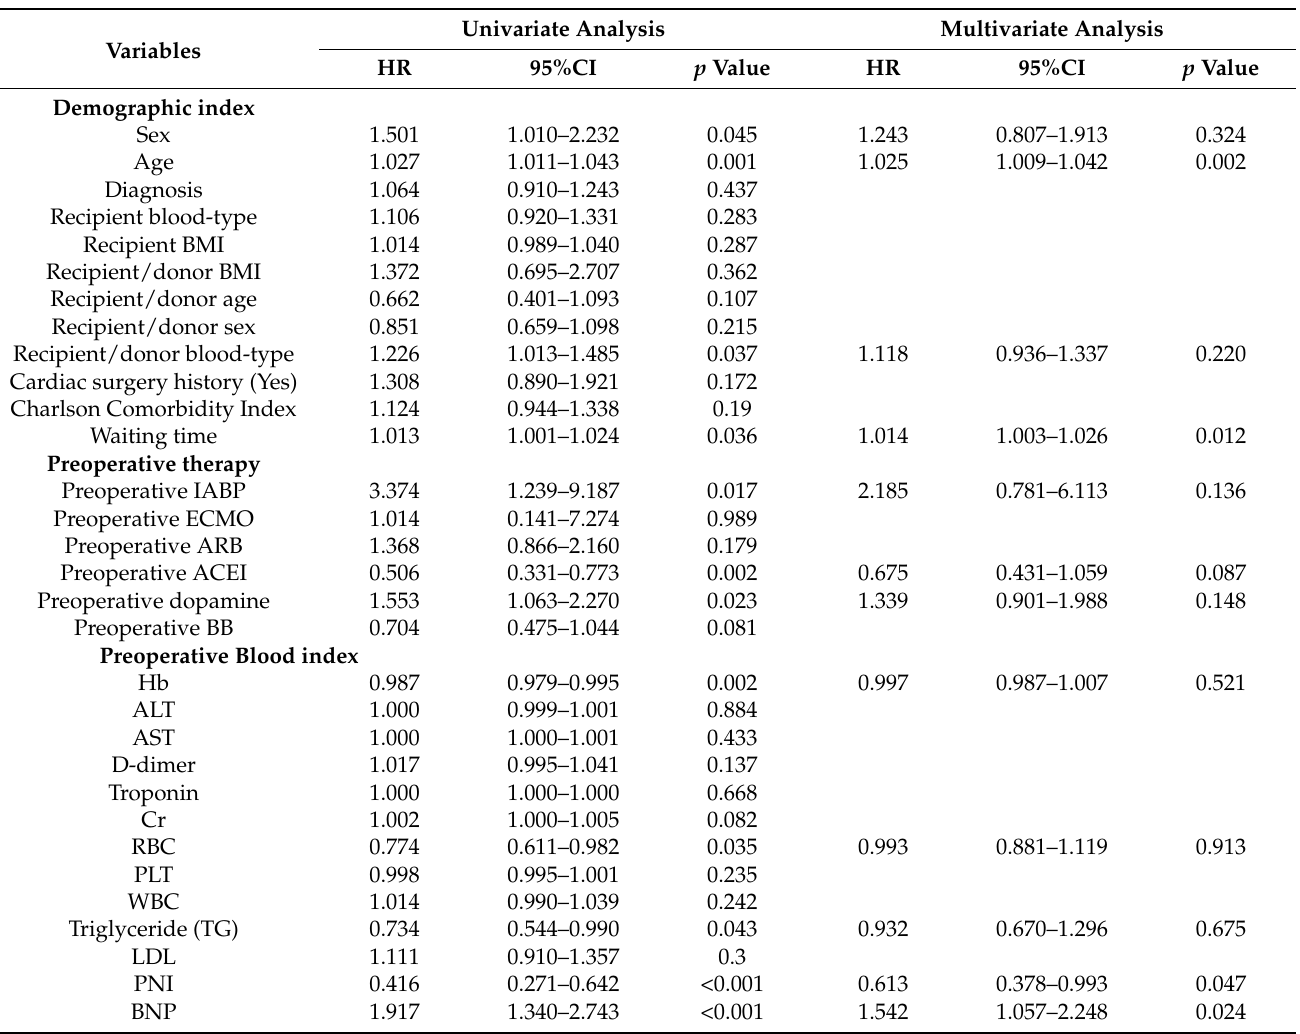
Table 2. Univariate and multivariate analysis of overall survival in patients with heart